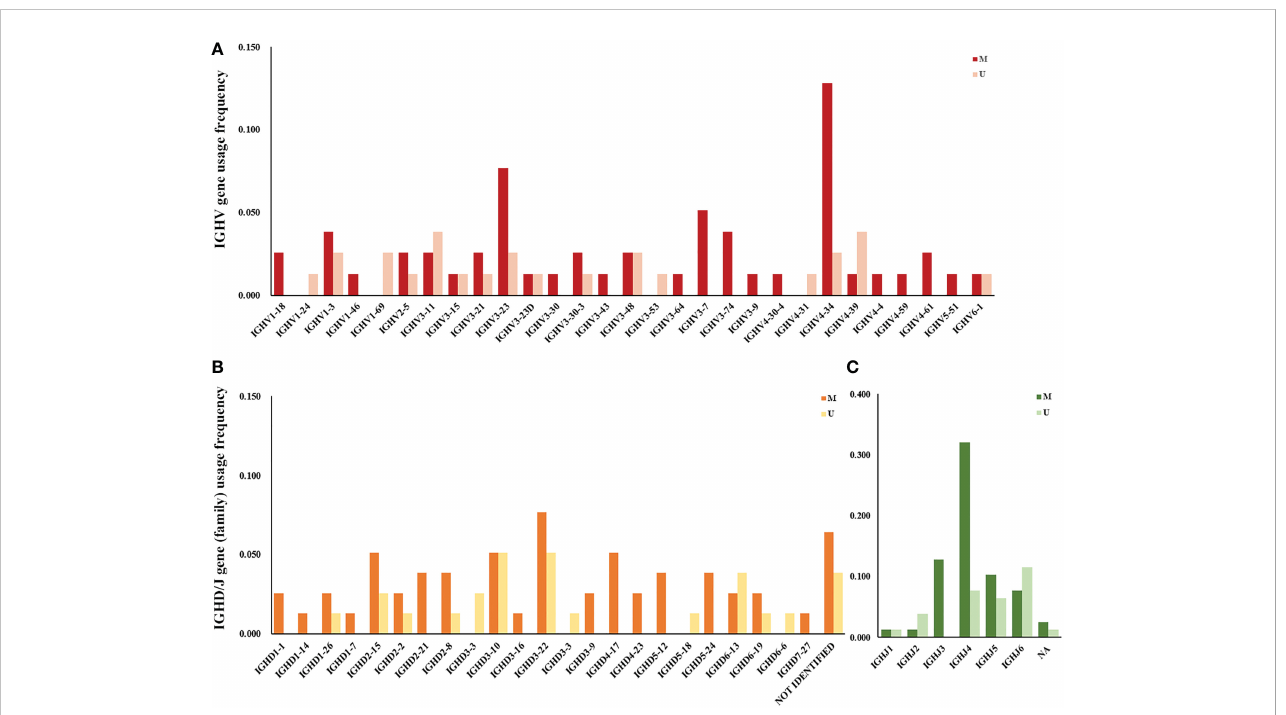
FIGURE 1 IGHV, IGHD, and IGHJ gene (subgroup) usage frequency in Chinese CLL patients. (A) V subgroup/gene usage frequency in Chinese CLL patients. Red columns represent cases with mutated IGHV regions, and pink columns represent cases with unmutated IGHV regions. (B) D subgroup/gene usage frequency in Chinese CLL patients. Orange columns represent cases with mutated IGHV regions, and yellow columns represent cases with unmutated IGHV regions. (C) J subgroup/gene usage frequency in Chinese CLL patients. Dark green columns represent cases with mutated IGHV regions, and light green columns represent cases with unmutated IGHV